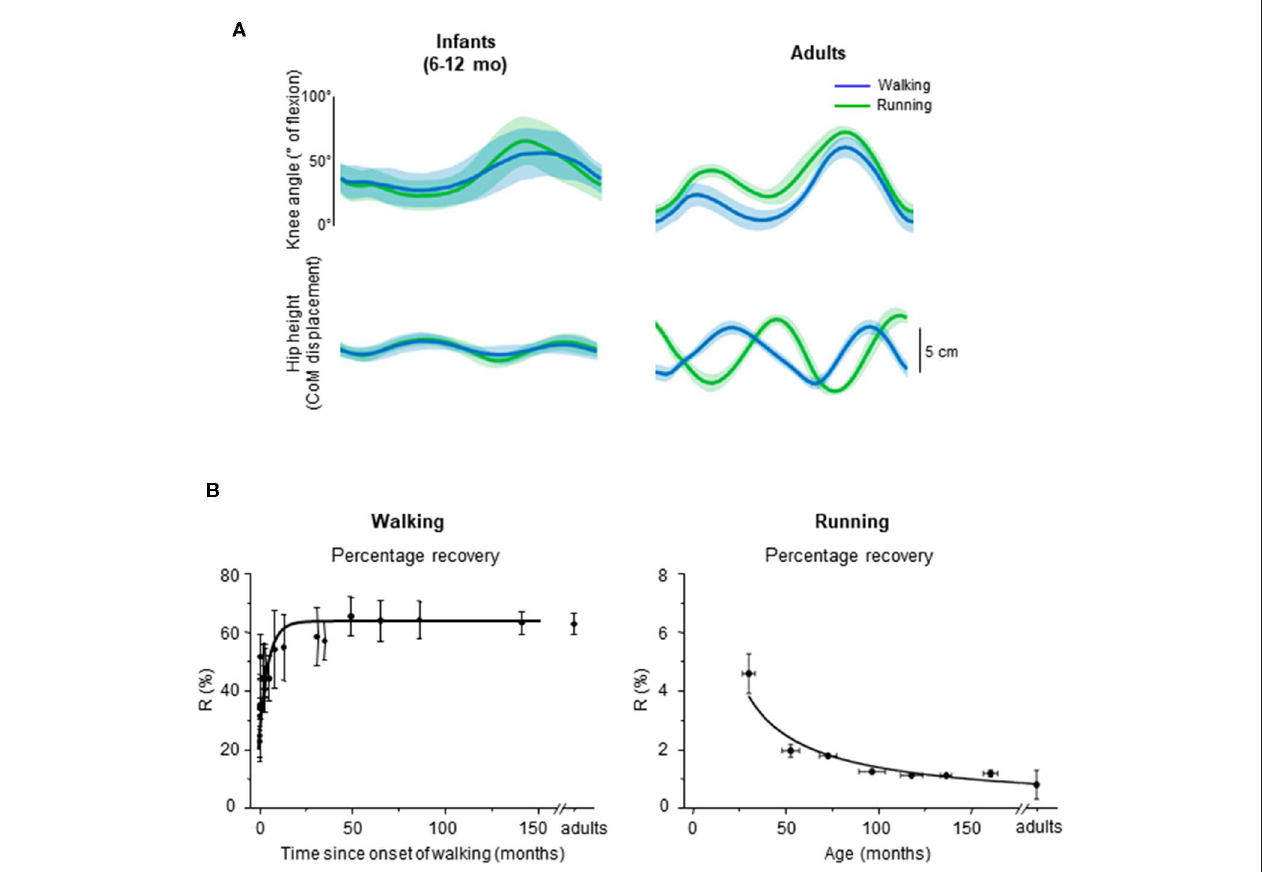
FIGURE 6 | Emergence of walking and running gait features during development. (A) comparison between knee angle (top) and hip vertical trajectory (bottom) in infants and adults, adapted from Vasudevan et al. (2016). Walking (blue) and running (green) gaits were defined based on the presence of double support period or flight phase, respectively. Note similar kinematic patterns in infants and distinct patterns in adults for both gaits. (B) percentage of recovery of mechanical energy ( R %) during walking as a function of the time after the onset of independent walking (left) (adapted from Ivanenko et al., 2004), and R % during running as a function of age (data from Schepens et al., 1998). During walking, a greater R % reflects a potentially better pendular energy exchange whereas during running, a smaller R % reflects a potentially better elastic energy